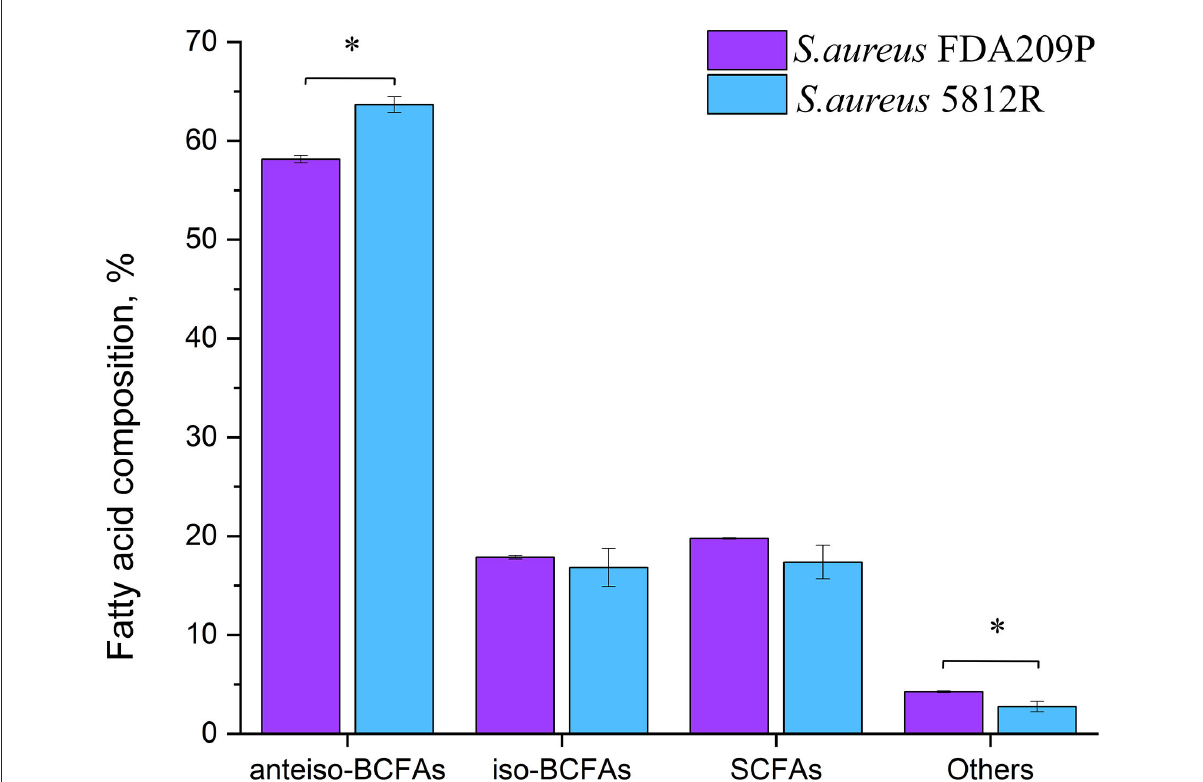
FIGURE3 The fatty acid composition of cytoplasmic membrane S. aureus FDA209P and S. aureus 5812R. The measurements were performed using gas chromatography–mass spectrometry. Y-axis is a relative proportion (%) of each group of fatty acids in relation to the total amount of identified fatty acids. The means plus standard deviations of the means of results from three independent experiments are shown (* p < 0.05).